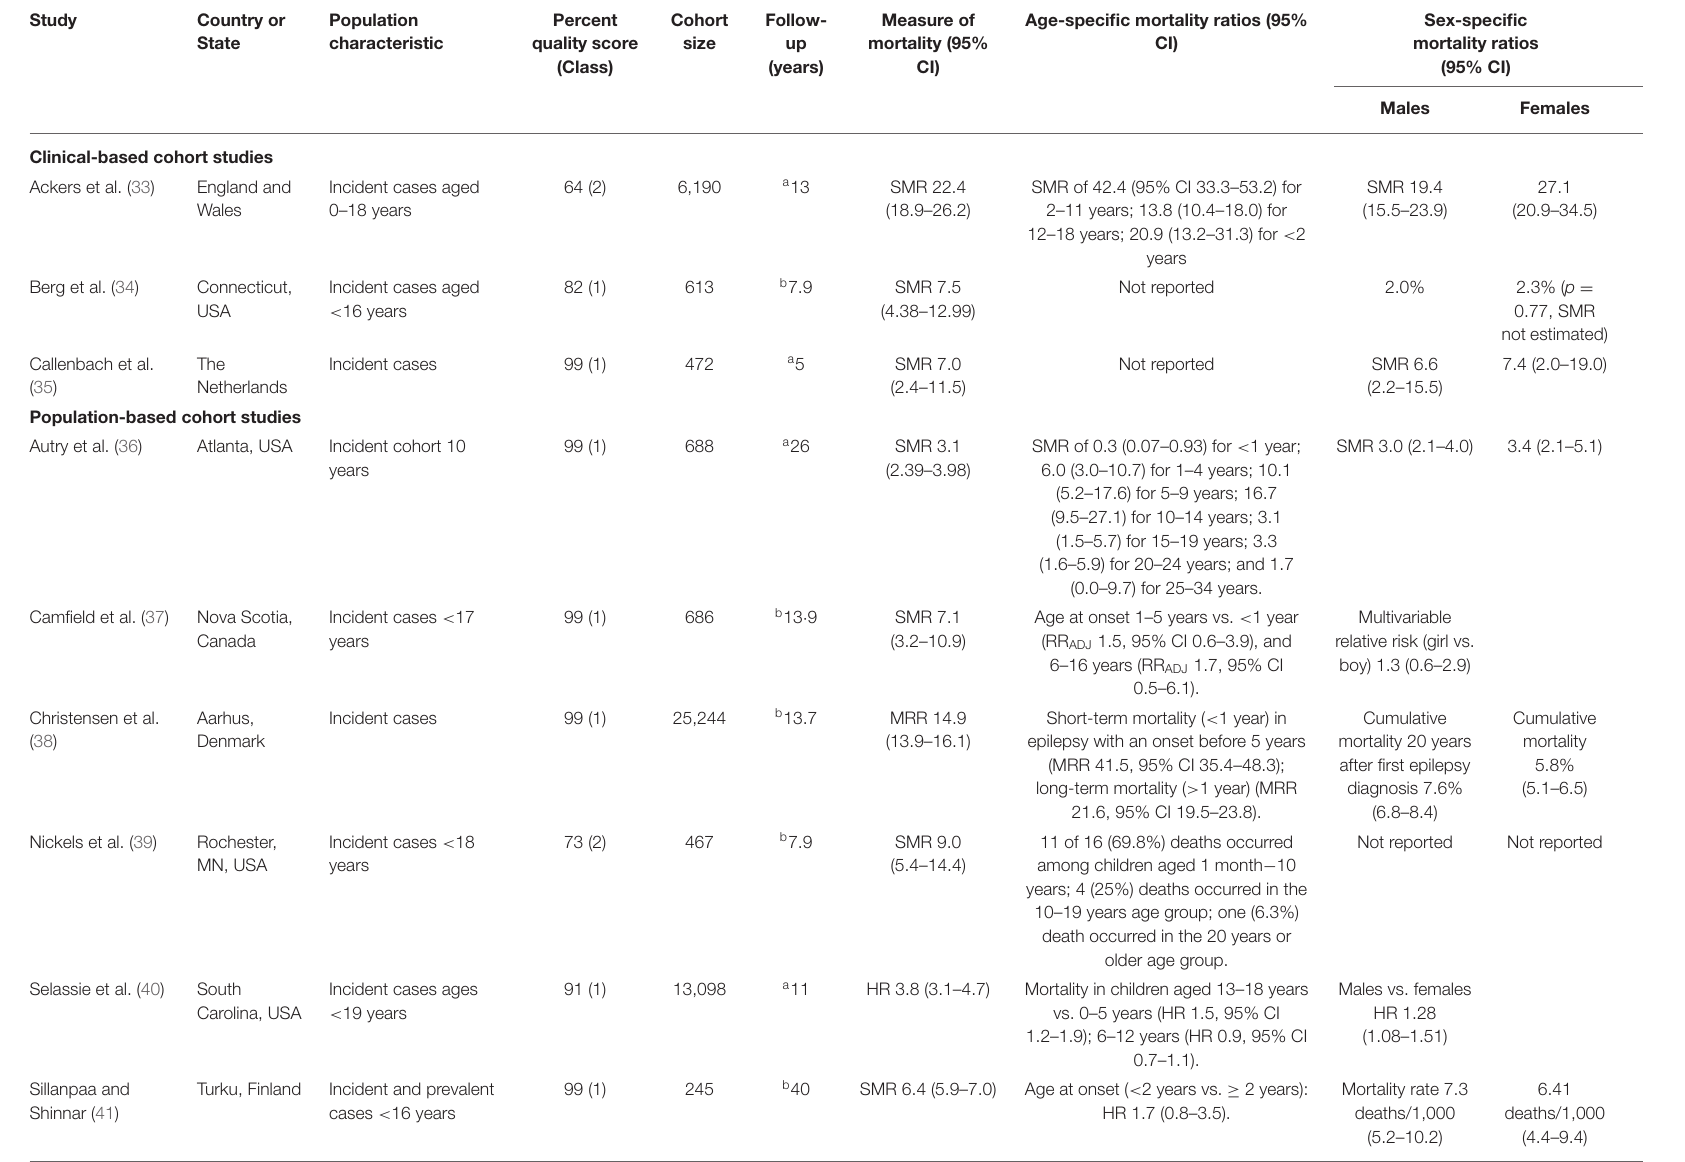
TABLE 2 | General study characteristics, overall risk, and mortality by age and sex in children with